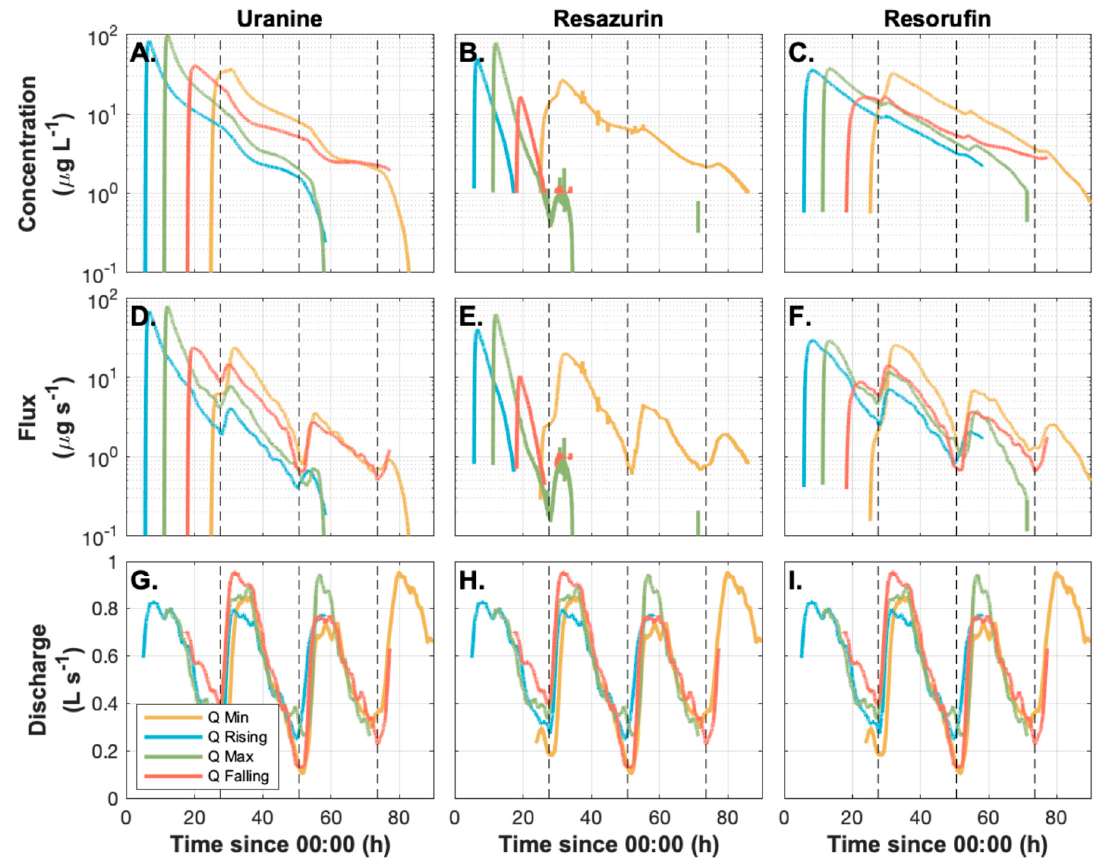
Figure 2. Time series of concentration (panels A – C ), mass flux (panels D – F ), and discharge (panels G – I ) for all experiments, and all tracers including Uranine (conservative; panels A, D, E), Resazurin (parent compound; panel B, E, H), and Resorufin (daughter product; panels C, F, I). The dashed vertical lines indicate the time of lowest discharge.